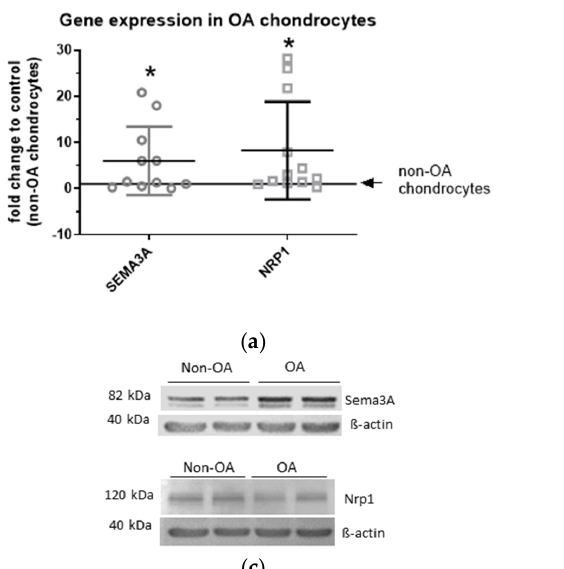
Figure 1. Expression of Sema3A and Nrp1 in chondrocytes from OA patients compared with non-OA donors. ( a ) Relative gene expression of SEMA3A and NRP1 in OA chondrocytes in comparison with non-OA chondrocytes. n = 11–12; one sample t -test; * p ≤ 0.05; ( b ) Relative protein expression